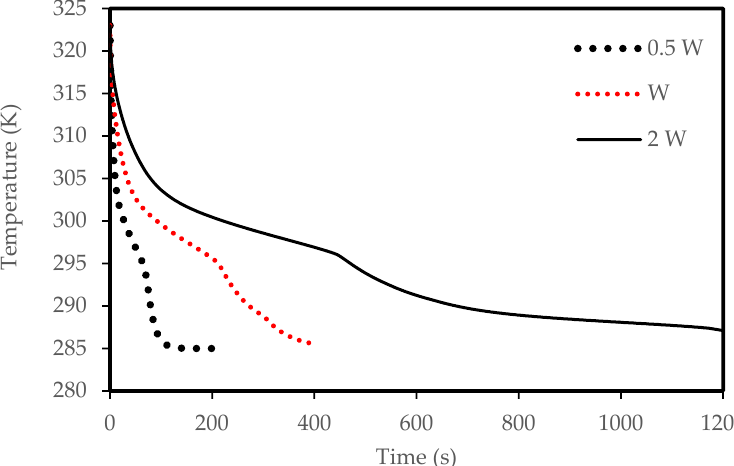
Figure 15. Temperature development in the horizontal corrugated channel for different widths for the solidification process.